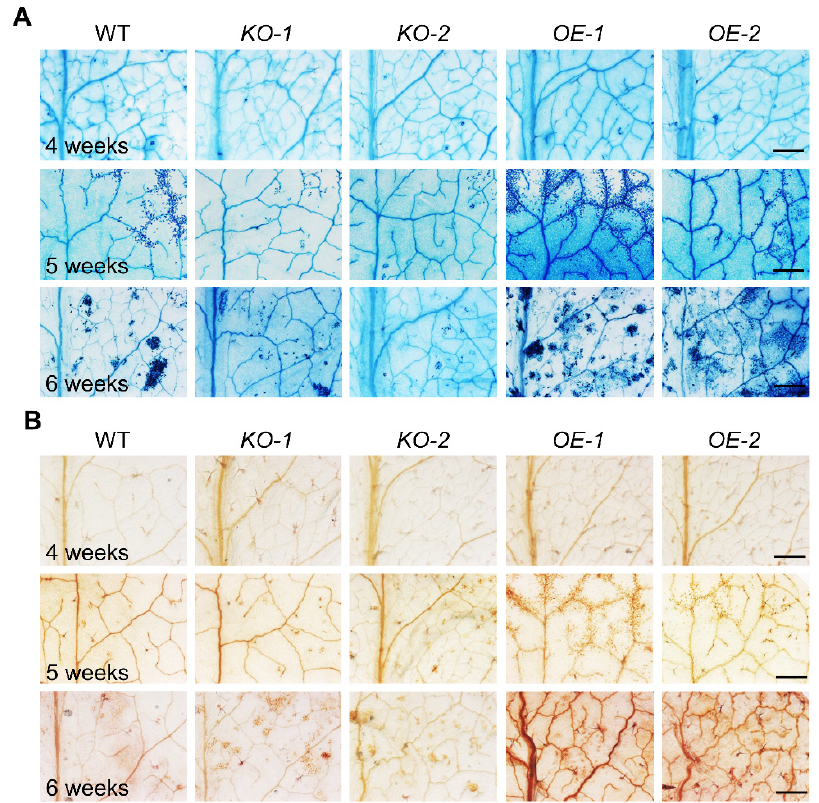
Figure 2. Overexpression of MACP2 showed accelerated cell death in rosettes. Trypan blue staining ( A ) and DAB staining ( B ) of wild-type, MACP2-KO mutants, and MACP2-OE rosettes after 4, 5, and 6-week development. MACP2-OEs obtained more cell death lesions and higher levels of H 2 O 2 , indicated by the brown color, than wild-type in the 5th and 6th weeks, while MACP2-KOs obtained less cell death and lower levels of H 2 O 2 than wild-type. Bar = 1 mm.